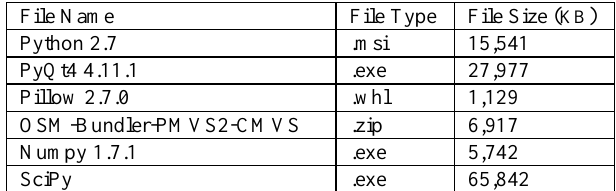
Table 2. Python Installation requirements: file types and